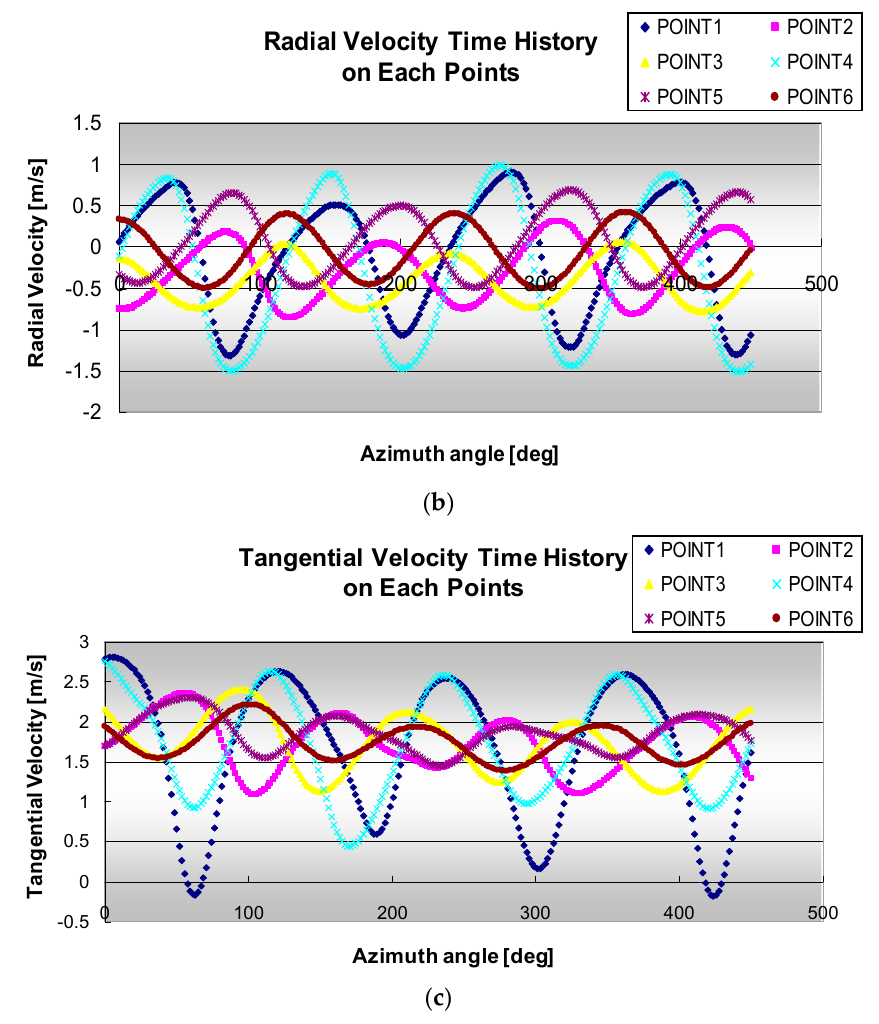
Figure 15. Velocity time history with varying azimuth angle. ( a ) Axial velocity time history, ( b ) radial velocity time history ( c ) tangential velocity time history. The flow angle (FA) and turbulence intensity ( 𝑇 (cid:3036) ) normalized by the rotor tip speed on the nacelle anemometer points are computed by Equations (8) and (9), and the time history of flow angle (FA) on each location is shown in Figure 16.